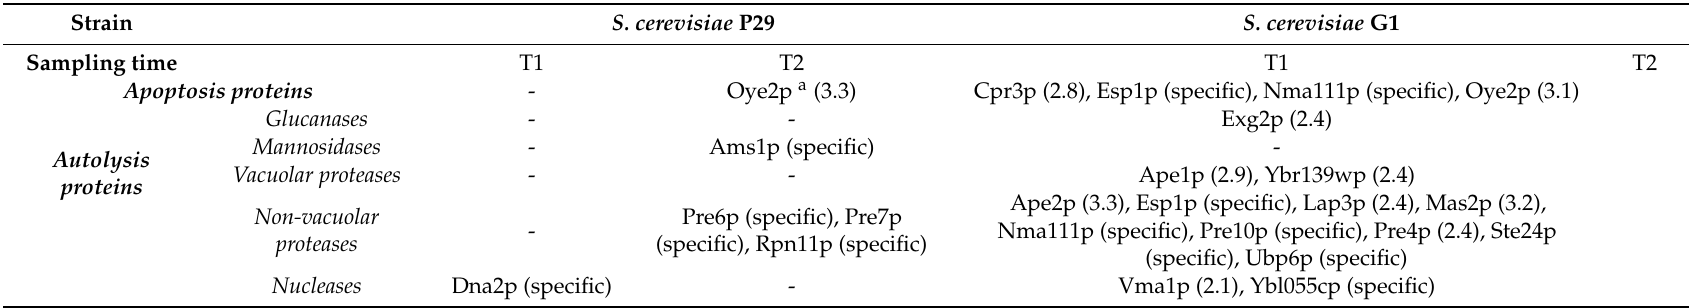
Table 3. List of over-represented and specific proteins related to apoptosis and autolysis under CO 2 overpressure condition (PC) detected at the middle of the second fermentation (T1) and 1 month after it (T2), in S. cerevisiae P29 and